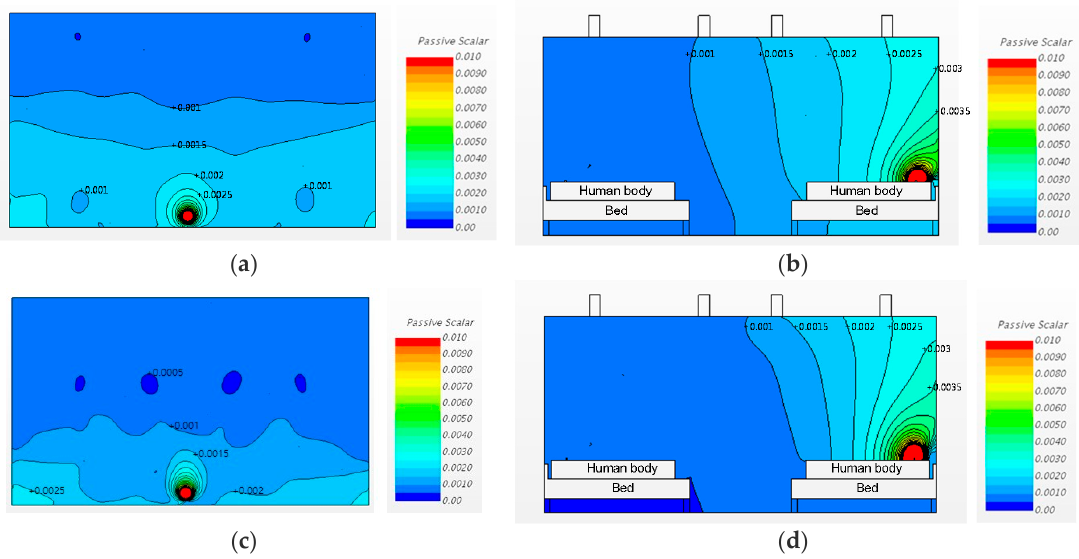
Figure 8. Airflow patterns and pathogen concentrations for Cases 1 and 2: ( a ) Case 1, plan view (h = 1.0 m); ( b ) Case 1, sectional view; ( c ) Case 2, plan view (h = 1.0 m); ( d ) Case 2, sectional view.